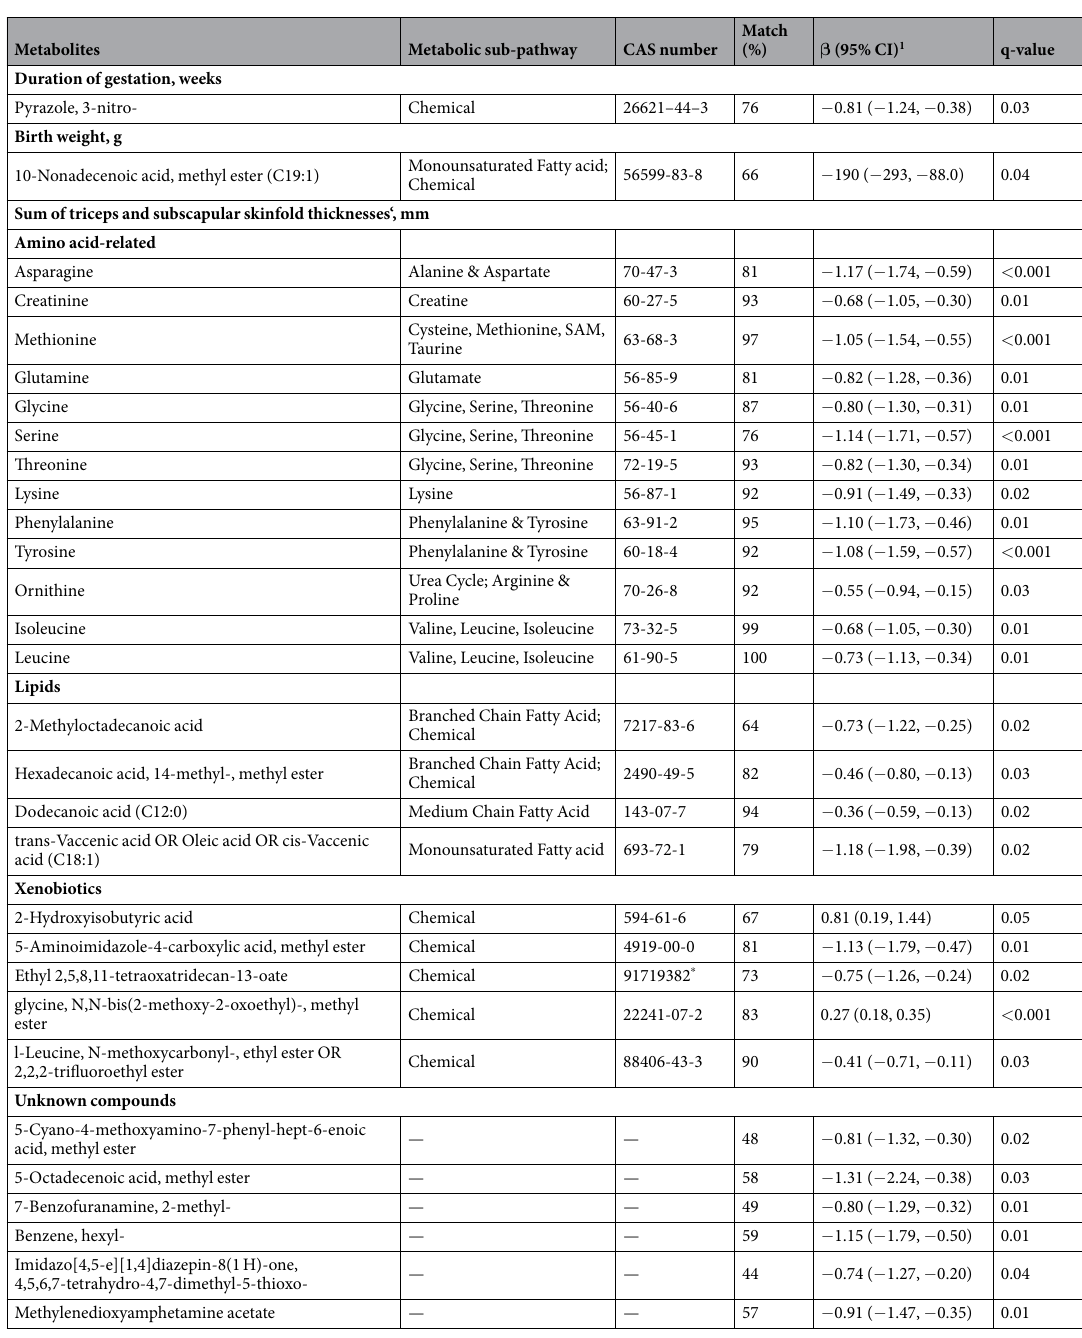
Table 2. Associations between maternal plasma metabolite levels and infant birth outcomes (q-value < 0.05). β values are linear regression coefficients per SD increase in metabolite levels, adjusted for infant sex and maternal age, parity, education, ethnicity, pre-pregnancy BMI, weight gain until 26–28 weeks of gestation,